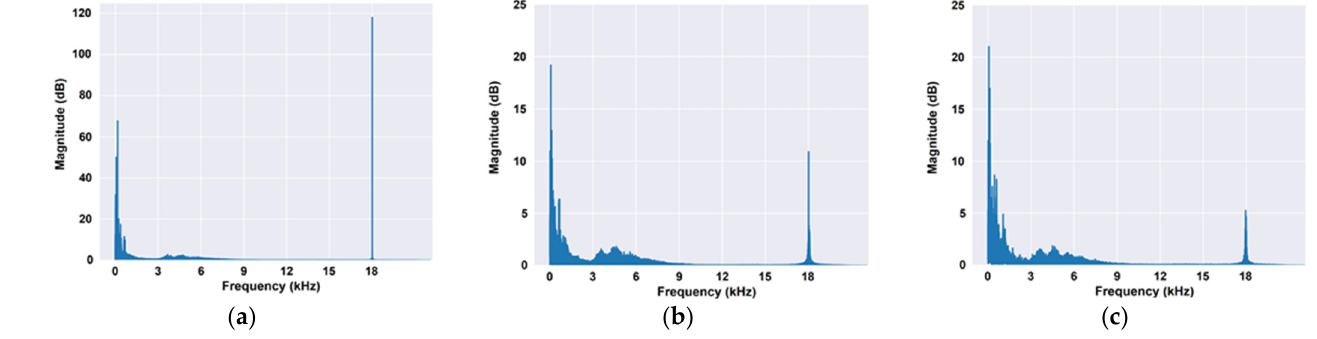
Figure 5. Fourier Transform Results from the Indoor Experiment: ( a ) ST, ( b ) MF_F, ( c ) MB_F.